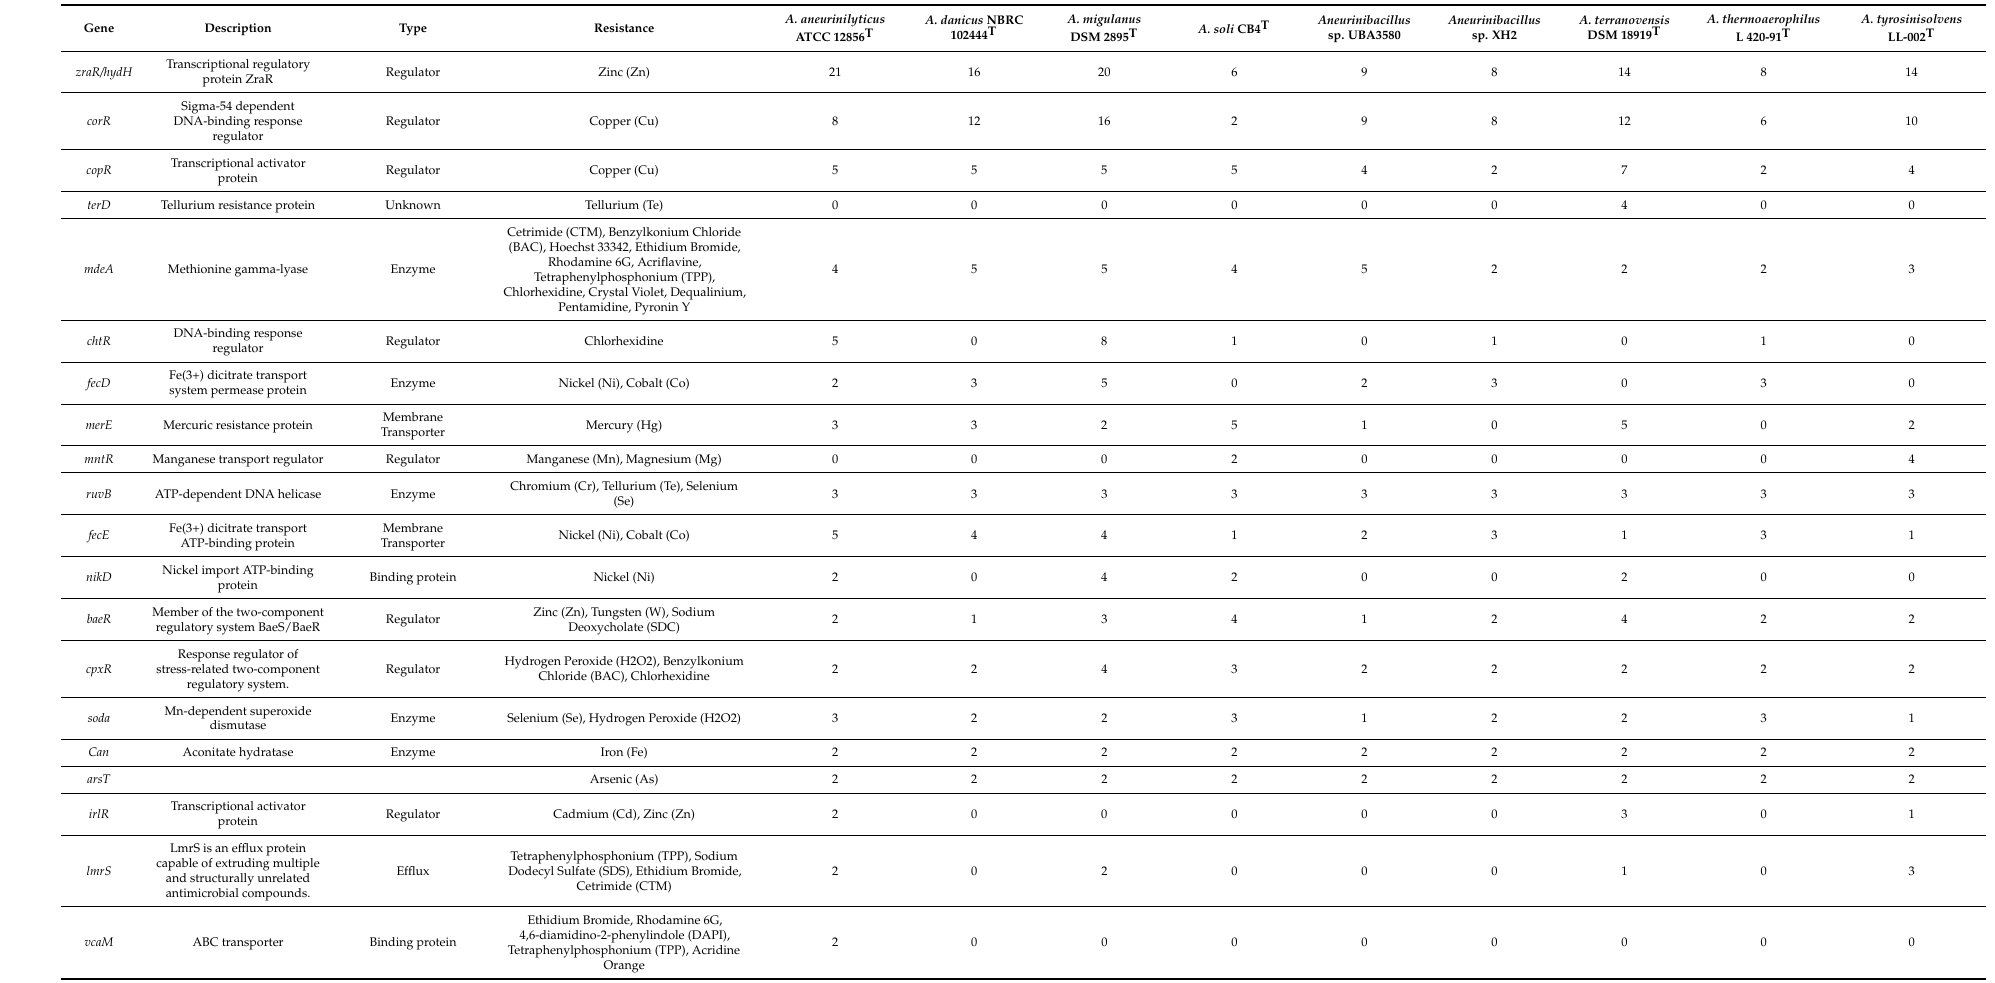
Table 5. Top 20 most abundant heavy metal resistance genes found in the genomes of nine Aneurinibacillus strains.